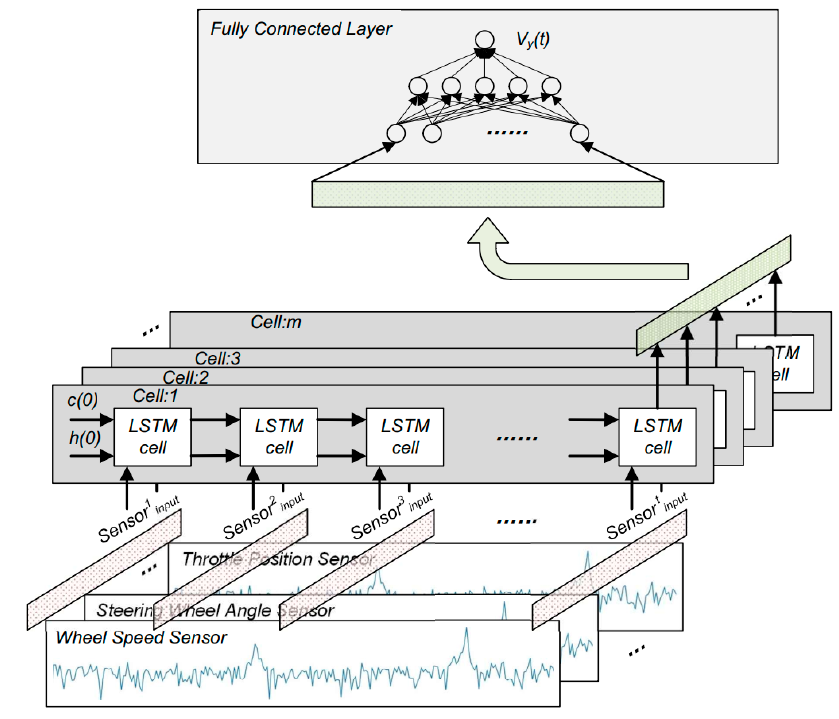
Figure 4. Proposed Network Architecture.